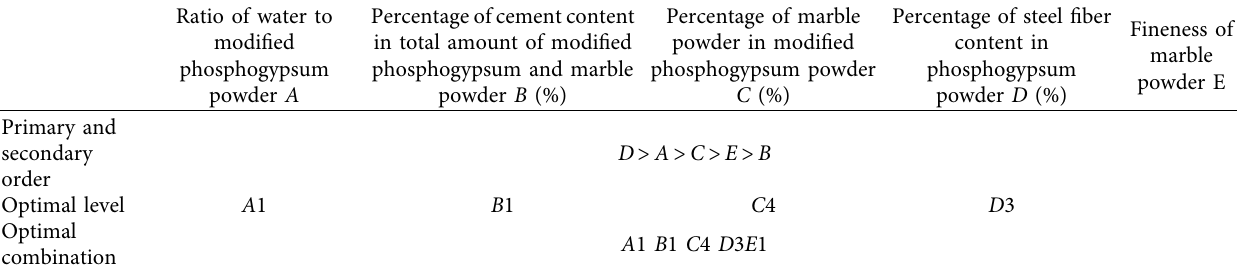
Table 16: Statistical table of the influencing factors of the 7d electrical characteristics.